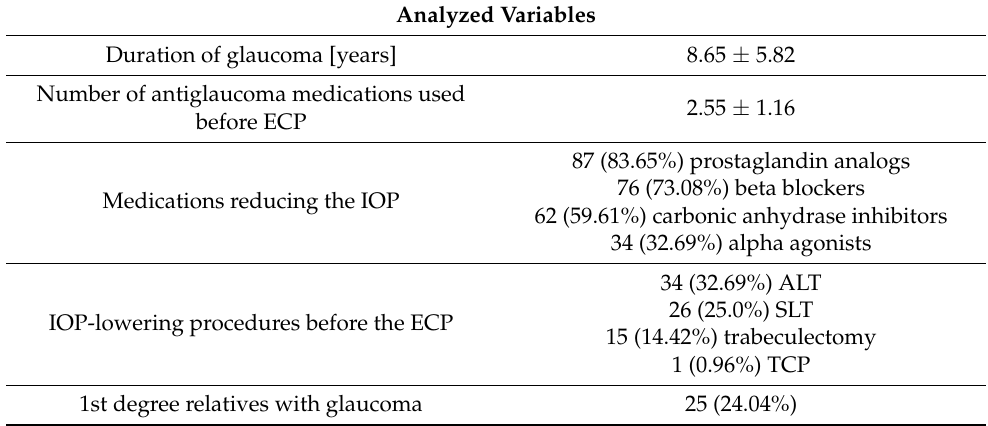
Table 1. Clinical characteristics of the patients treated with endoscopic